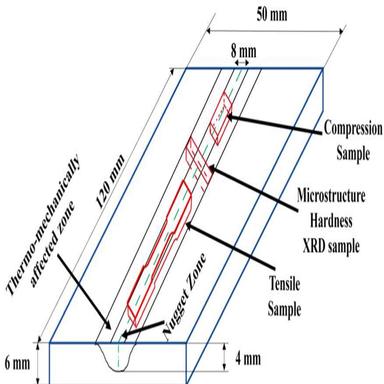
A schematic of FSPed material showing the procedure for cutting samples for various characterizations.